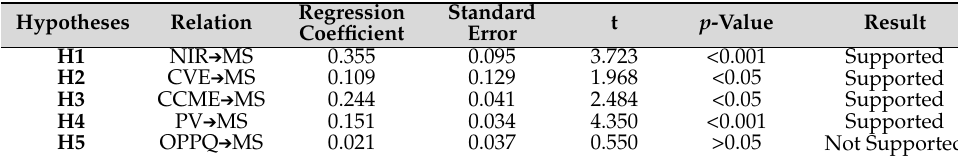
Table 4. Research hypotheses and statistical